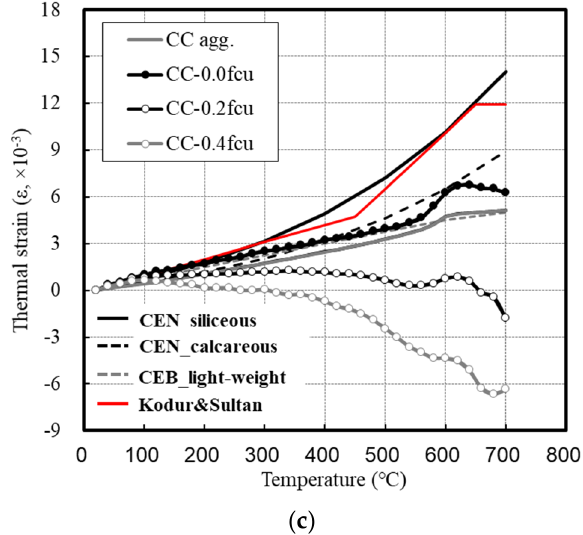
Figure 10. Strain of concrete with heating and loading conditions. ( a ) GC. ( b ) AC. ( c ) CC.